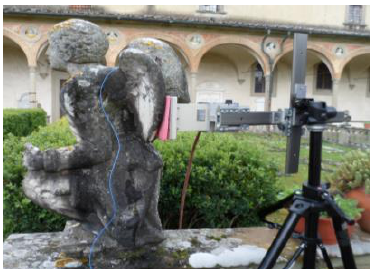
Figure 3. Microwave heating treatment on the biological patina growing on a marble statue